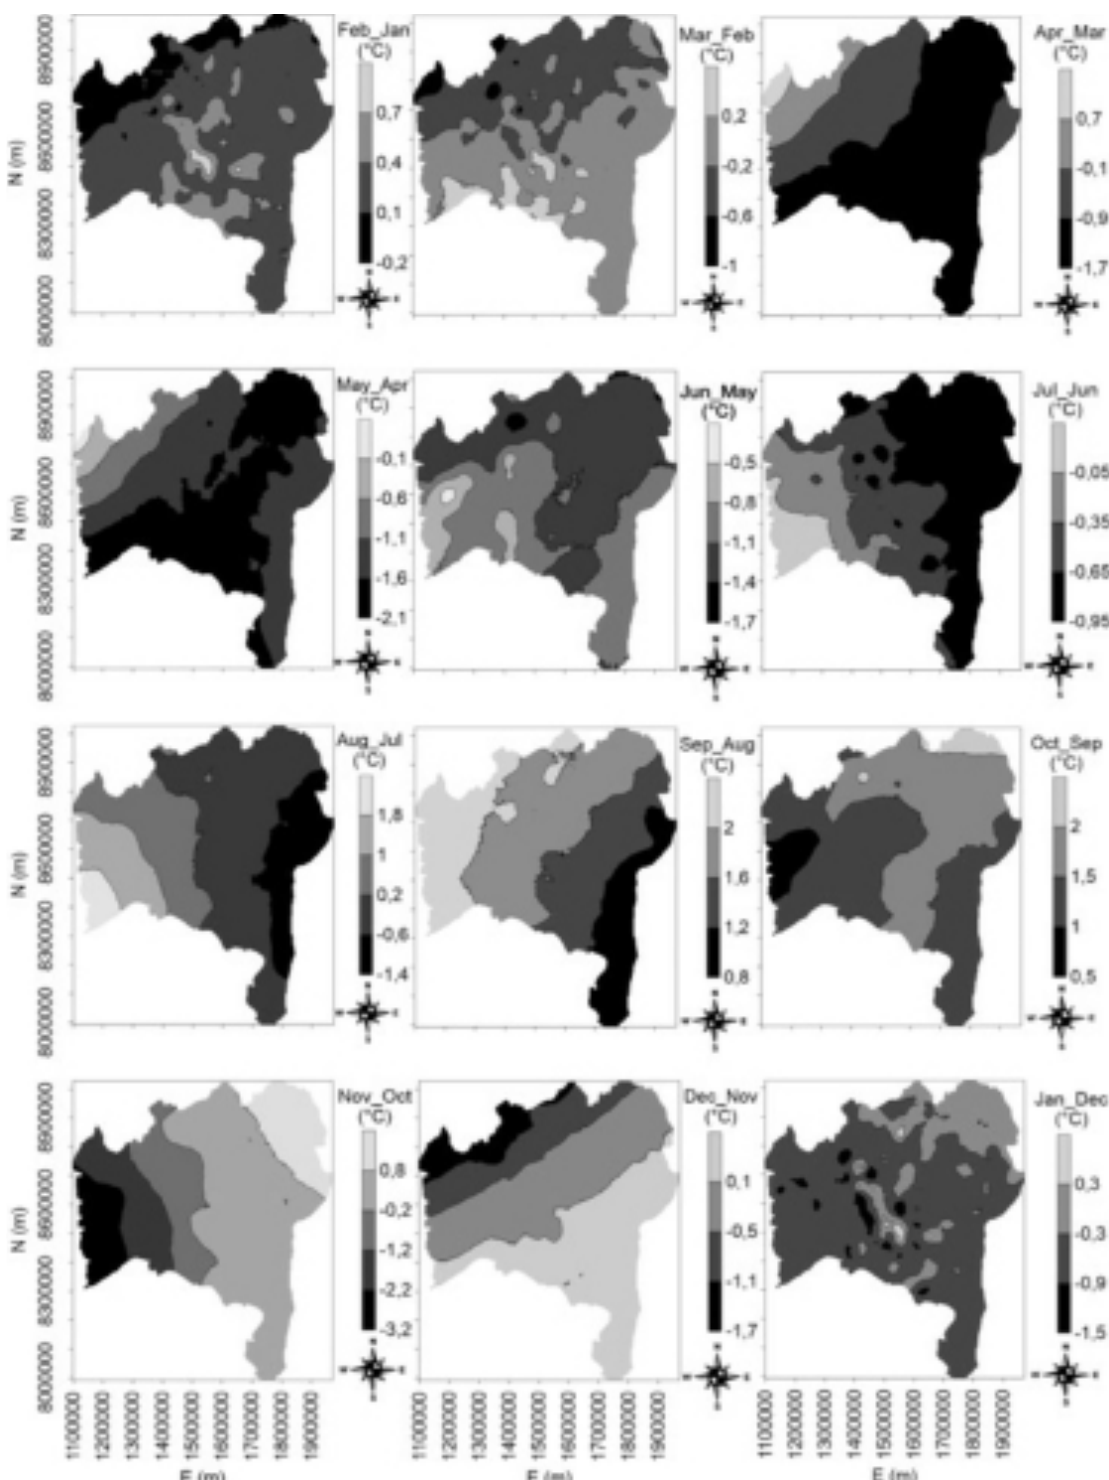
Figure 2. Thematic maps of the month-to-month temporal evolution of mean air temperature for the state of